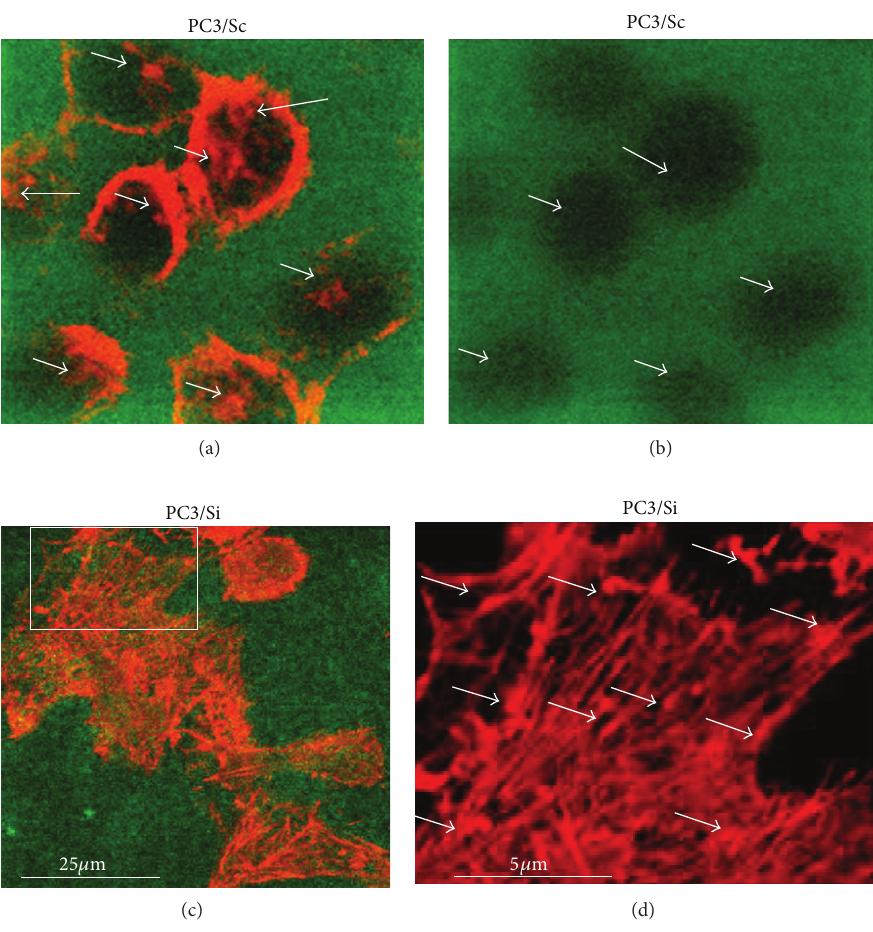
Figure 5: Determination of invasion property of PC3/Si and PC3/Sc cells using gelatin degradation assay. The ability of PC3 cells knockdown of MMP9 to degrade the gelatin matrix was determined by culturing PC3 cells (PC3/Sc and PC3/Si) on a FITC-conjugated gelatin matrix (green). Cells were found within the degraded matrix (a). Actin staining is shown in red (a), (c), and (d). Invadopodia are indicated by arrow heads (a). Areas of degradation of the matrix are indicated by green arrows (b). The rectangular field in (c) is enlarged in (d). Focal adhesions are indicated by arrows (d). These results represent one of several experiments